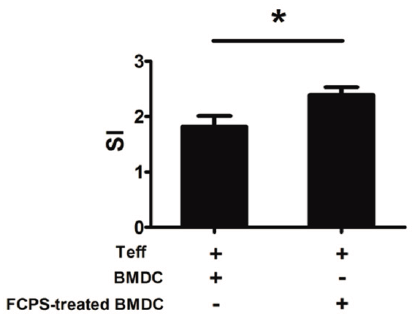
Figure 4. FCPS enhances the immunostimulatory capacity of DCs. BMDCs were stimulated with FCPS (100 μ g/mL) for 48 h. Cells were harvested and treated with mitomycin C and then co-cultured with CD4 + CD25 − Teff cells in the presence of anti-CD3 mAb for 72 h. The proliferation was measured via the MTT assay. Results are presented as means ± SD from three independent experiments. * p <